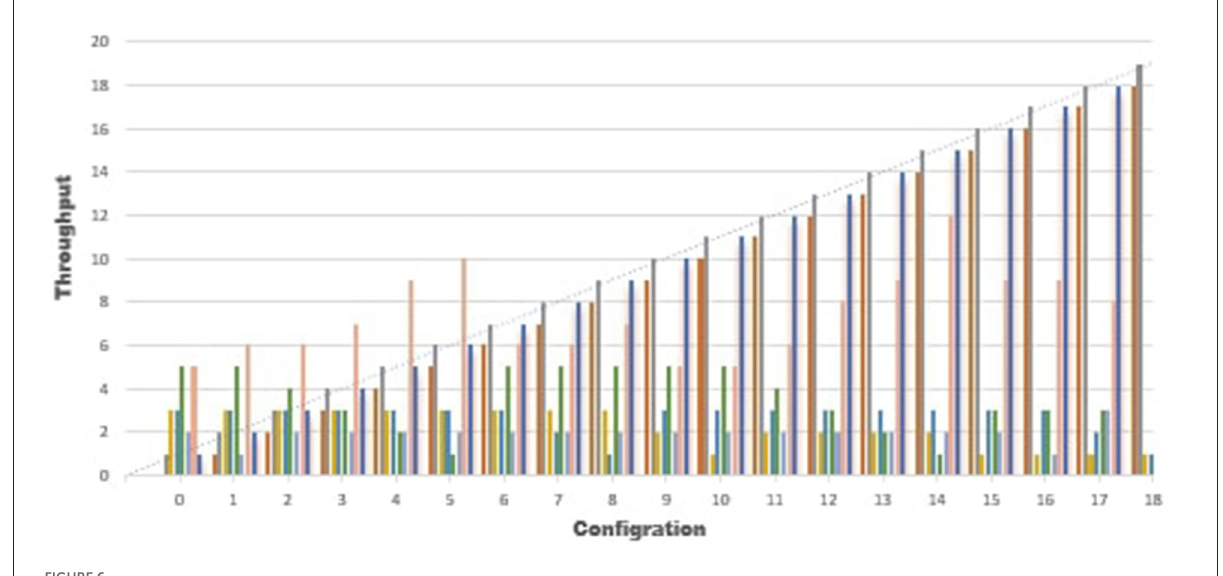
FIGURE6 Analysis of performance.